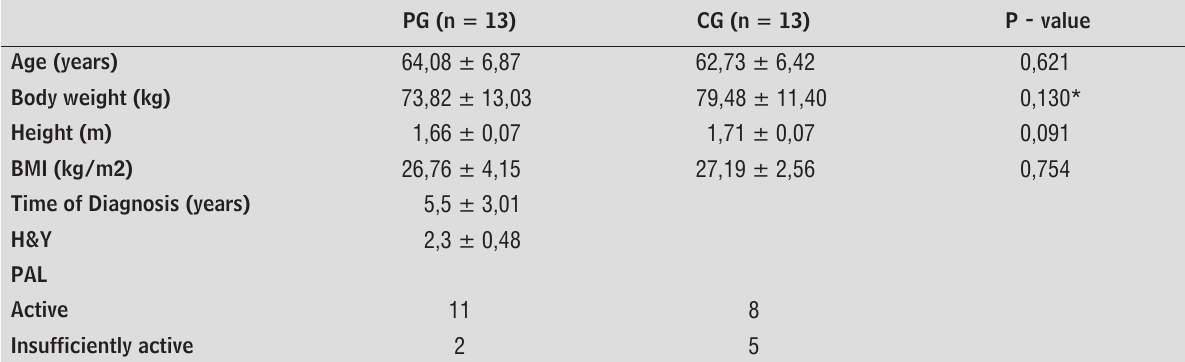
Table 1 – Characteristics of participants (average values ± standard deviation) PG (n =